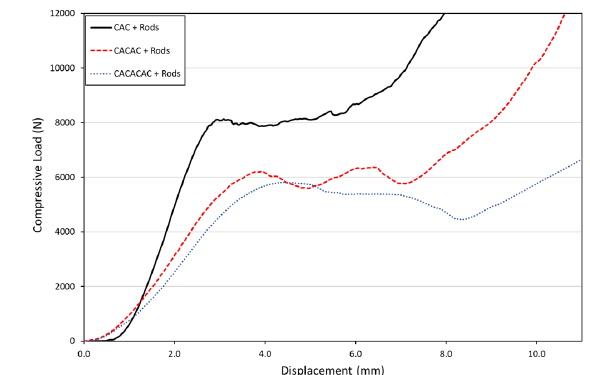
Figure 12: Load-displacement data of panels with two layers of card- board and one layer of aluminum in between (CAC), three layers of cardboard with one layer of aluminum in between each cardboard layer (CACAC), and four layers of cardboard with one layer of alu- minum in between each cardboard layer (CACACAC).